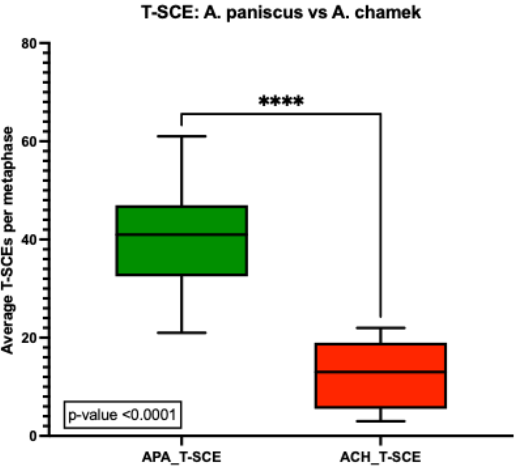
Figure 7. Average number of T-SCEs detected in A. paniscus vs. A. chamek : The average number of exchanges was significantly higher in A. paniscus showing an average of 40 T-SCEs per metaphase compared to 12 T-SCEs per metaphase in A. chamek ( p < 0.0001). Statistical analysis was done using a one-way Anova test (**** p < 0.0001).